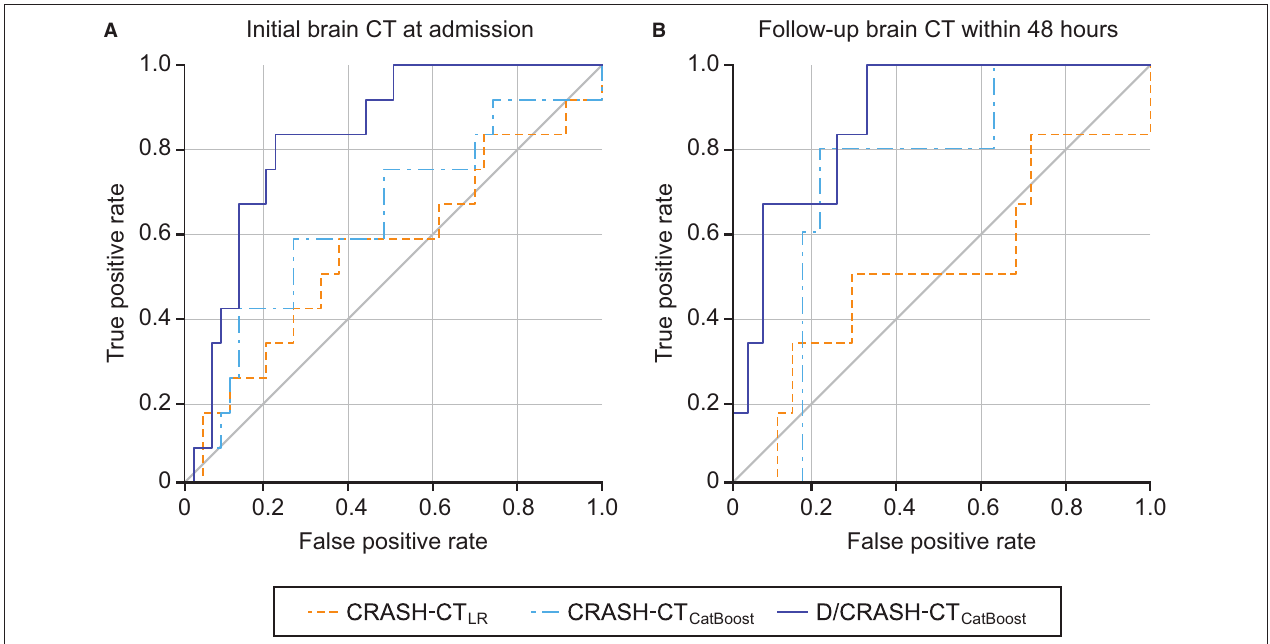
FIGURE 4 | ROC curves of the prognostic models for the differentiation of favorable and unfavorable outcomes based on the initial brain CT at admission (A) and follow-up brain CT within 48h (B) by the LOOCV. Orange = CRASH-CT LR , blue = CRASH-CT CatBoost , indigo = D/CRASH-CT CatBoost .